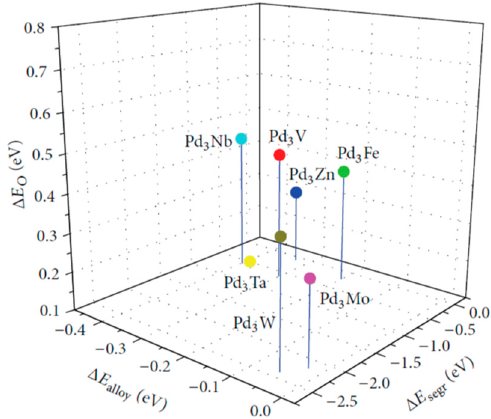
Figure 7. Three-dimensional optimization: High stability and ORR catalytic activity [102].